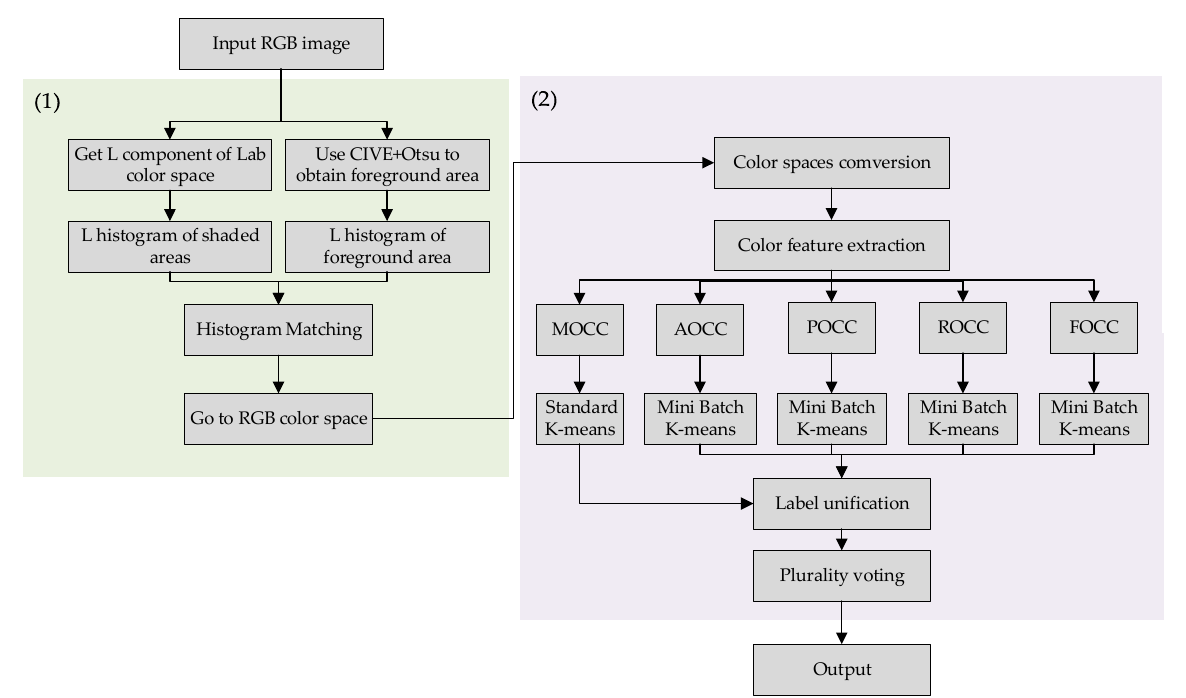
Figure 3. Flowchart of the proposed method. Where AOCC is the color channel with the highest accuracy value, POCC is the color channel with the highest precision value, ROCC is the color channel with the highest recall value, FOCC is the color channel with the highest F1 value, and MOCC is the color channel with the highest mean value of above four indicators.